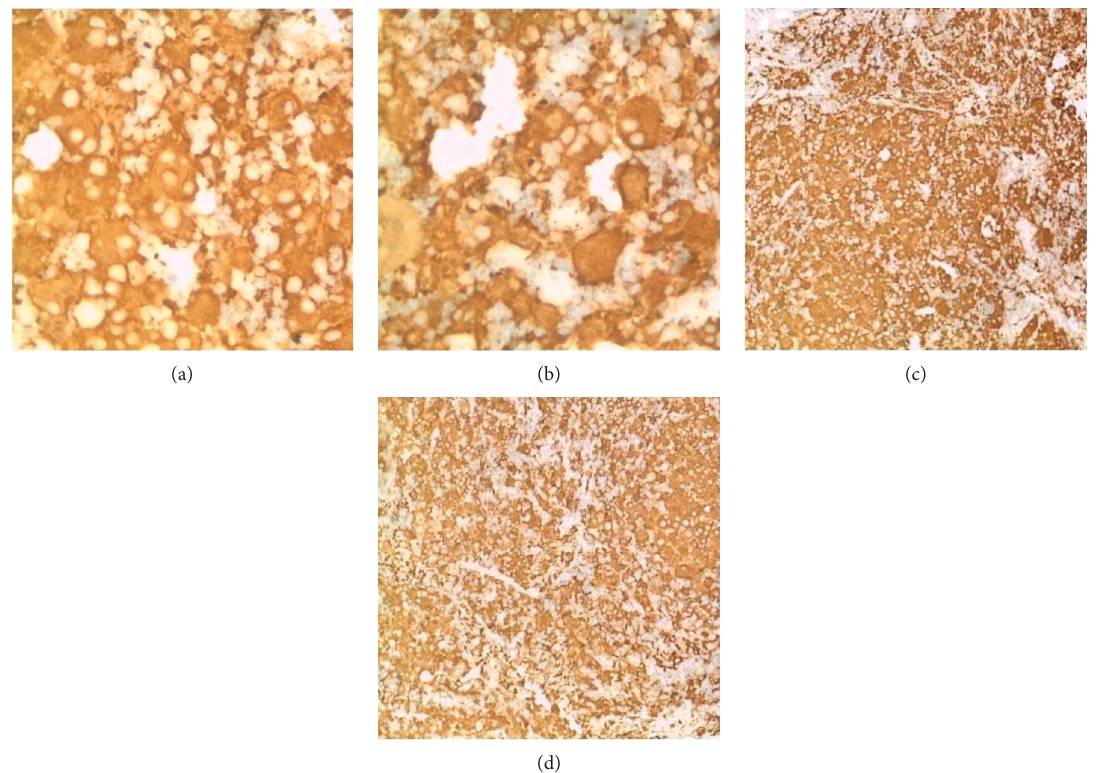
Figure 2: (x100-C&D and x400-A&B) - shows diffuse cytoplasmic staining of histiocytes for S100 (2C&2D) with negative staining for engulfed inflammatory cells- emperipolesis